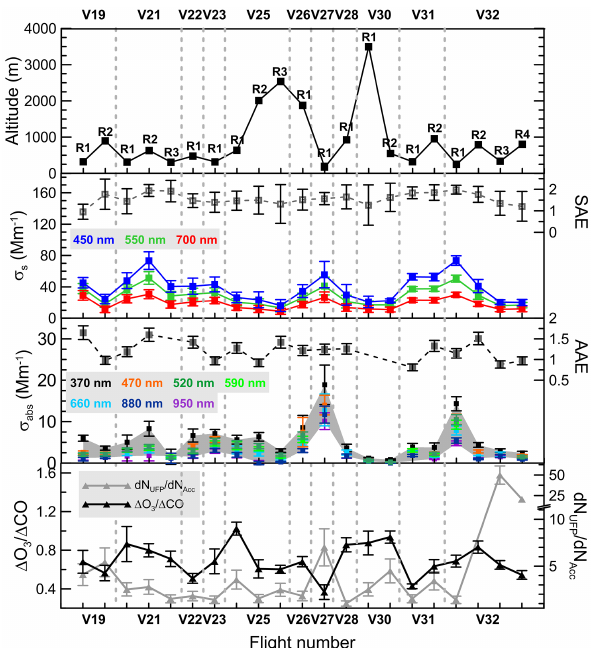
Figure 3. Averages over the different TRAQA straight levelled runs (SLRs) of the measured altitude, spectral scattering coefficient ( σ s ; 450, 550, and 700nm), scattering Ångström exponent (SAE), spectral absorption coefficient ( σ abs ; 370, 470, 520, 590, 660, 880, and 950nm), absorption Ångström exponent (AAE), ozone en- hancement factor ( (cid:49) O 3 /(cid:49) CO) and ultrafine-to-accumulation ratio (d N UFP / d N Acc ) . Uncertainties indicate the 1 σ standard deviation. The x axis indicates the flight number (19 to 32 for flights V019 to V032); each point for the same flight number represents a different SLR.